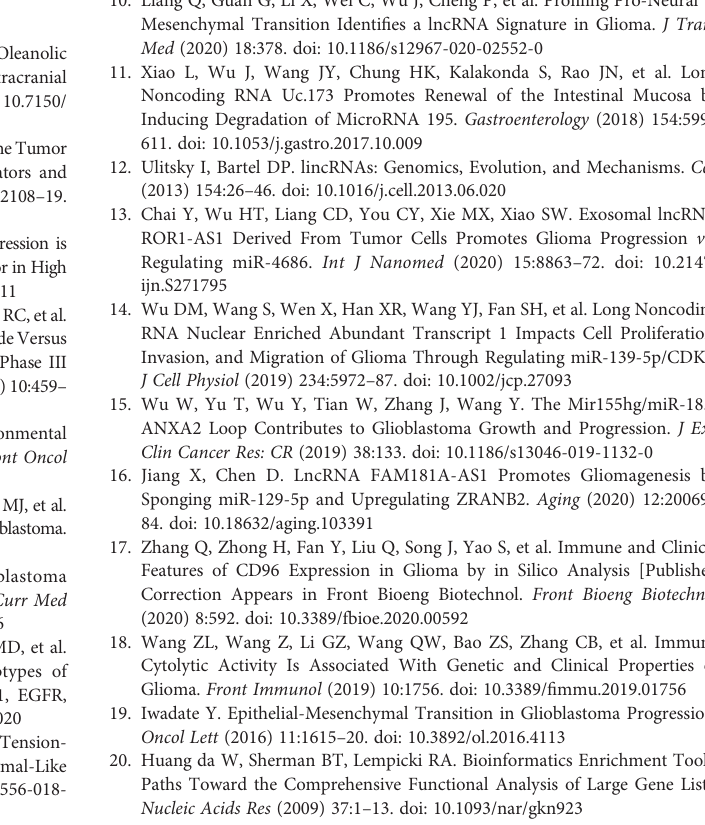
Supplementary Figure 1 | Construction of MES-related lncRNAs prognostic models in glioma patients. (A) The forest plot showing the candidate 18 MES- relatedlncRNAscorrelated withOSbyunivariateCoxanalysisintheTCGAdataset. (B) Multivariate Cox analysis showing the 10 MES-related lncRNAs correlated with OS in the TCGA data set. Supplementary Figure 2 | PCA between low- and high- risk groups based on the 10 MES-related lncRNAs expression pro fi les. Supplementary Figure 3 | The relative expression of the remaining 7 lncRNAs contained in the prognostic model. (A) Differences in GDNF-AS1 expression between the normal and glioma groups from the TCGA and GTEX data sets. (B) Differences in CRNDE expression between the normal and glioma groups from the TCGA and GTEX data sets. (C) Differences in FAM201A expression between the normal and glioma groups from the TCGA and GTEX data sets. (D) Differences in AGAP2-AS1 expression between the normal and glioma groups from the TCGA and GTEX data sets. (E) Differences in RNF219-AS1 expression between the normal and glioma groups from the TCGA and GTEX data sets. (F) Differences in LINC00906 expression between the normal and glioma groups from the TCGA and GTEX data sets. (G) Differences in HAR1A expression between the normal and glioma groups from the TCGA and GTEX data sets. **p < 0.01; ***p < 0.001. Supplementary Figure 4 | Knockdown of DGCR10, HAR1B, and SNHG18 impact the LN18 and U251 cell migration and invasion ability. Representative imaging (A, B) or counting (D, E) of migration assays after knockdown of DGCR10 and HAR1B in LN18 cell lines. Representative imaging (C) or counting (F) of migration assays after knockdown of SNHG18 in U251 cell lines. Representative imaging (G, H) or counting (J, K) of invasion assays after knockdown of DGCR10 and HAR1B in LN18 cell lines. Representative imaging (I) or counting (L) of invasion assays after knockdown of SNHG18 in U251 cell lines. Scale bar, 200 m m; **p < 0.01; ***p <